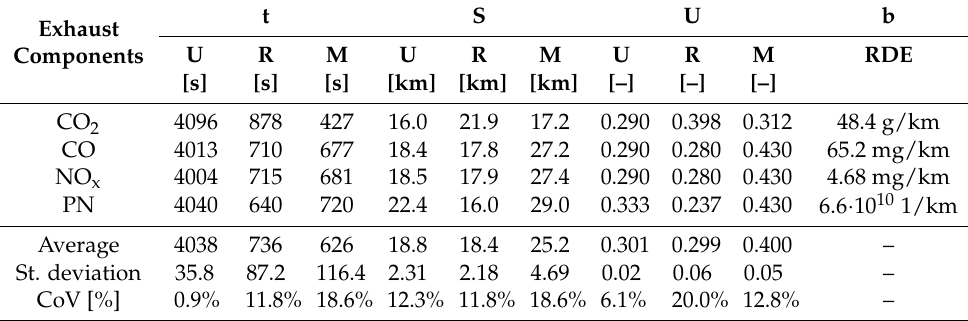
Table A3. Road emissions for the RDE test (assuming constant exhaust emission intensity)—output data obtained from the algorithm and the proposed values for the generalized test (Vehicle B).